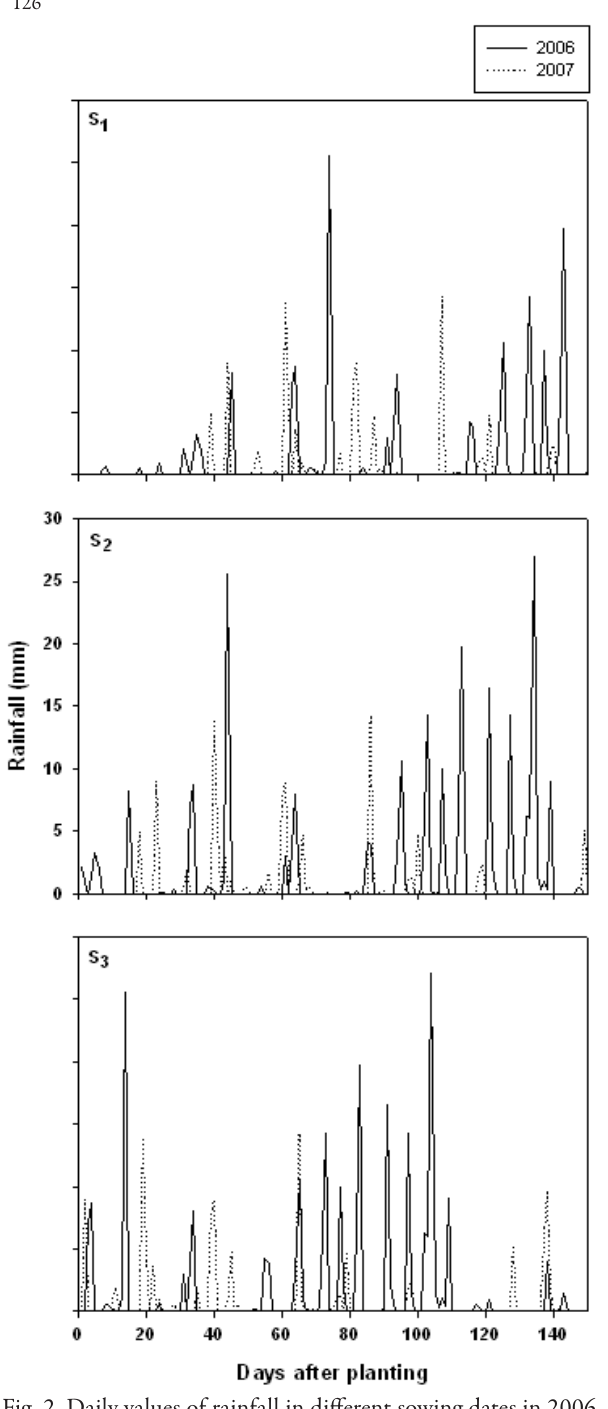
), mid November (S 1